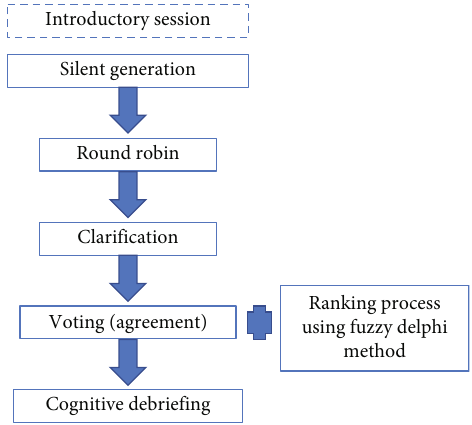
Figure 1: Study fl ow chart by incorporating the fuzzy Delphi method in nominal group technique. Modi fi cation based on work of McMillan et al. [20]. Table 1: Likert scale fuzzy numbers.